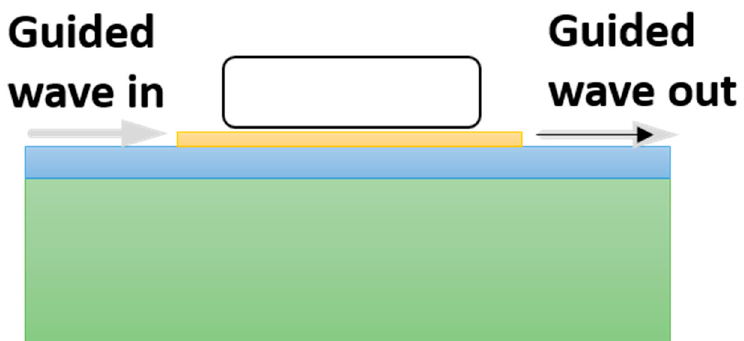
Figure 6. Excitation of the surface plasmons by waveguide coupling. Green layer indicates substrate, blue indicates waveguide, yellow indicates metal film, and black rectangle on the top indicates the dielectric [46].